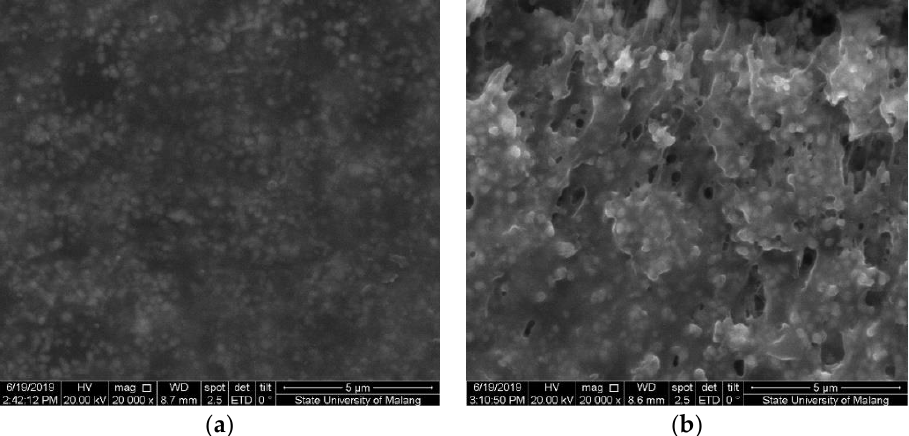
Figure 6. Scanning electron microscopy (SEM) image of membranes M221 ( a ) and M221-Fe 3 O 4 nanoparticles ( b ).